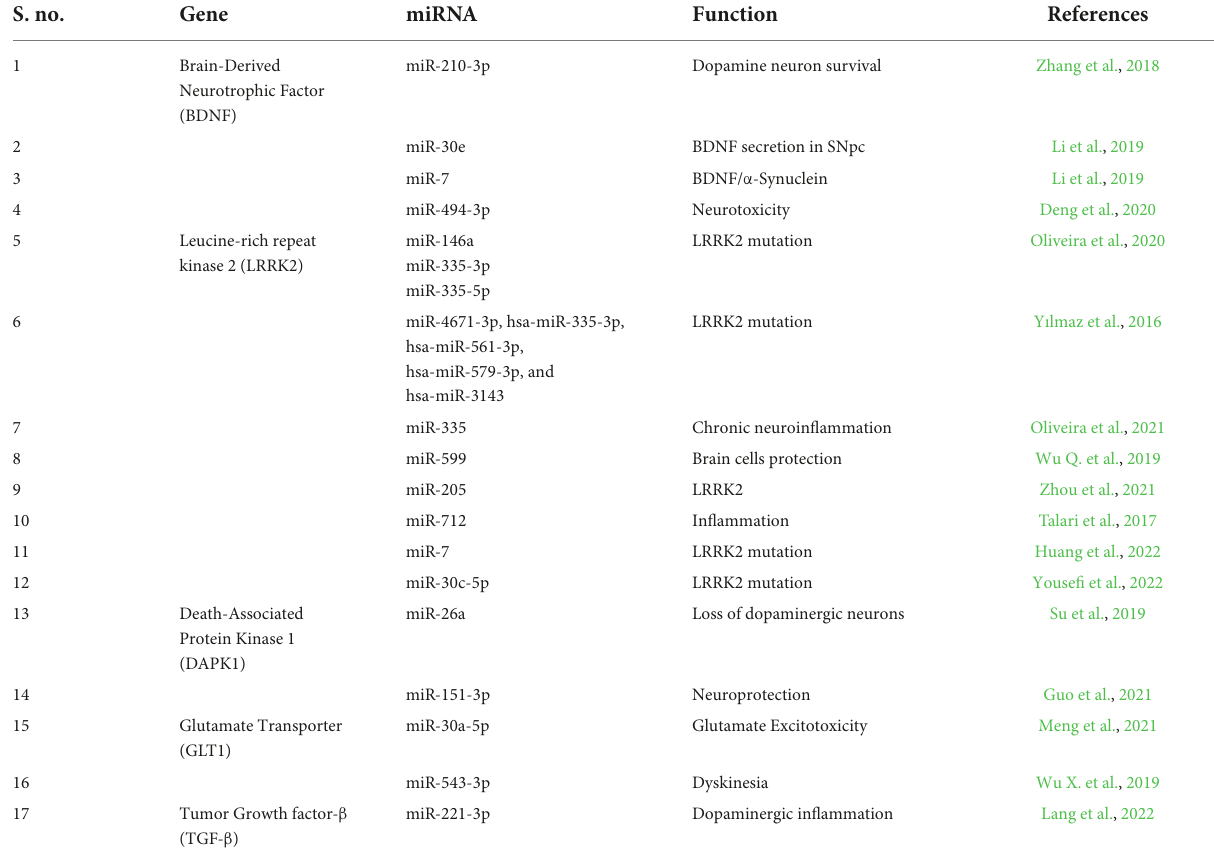
TABLE 3 miRNA regulating specific genes in Parkinson’s disease. S.